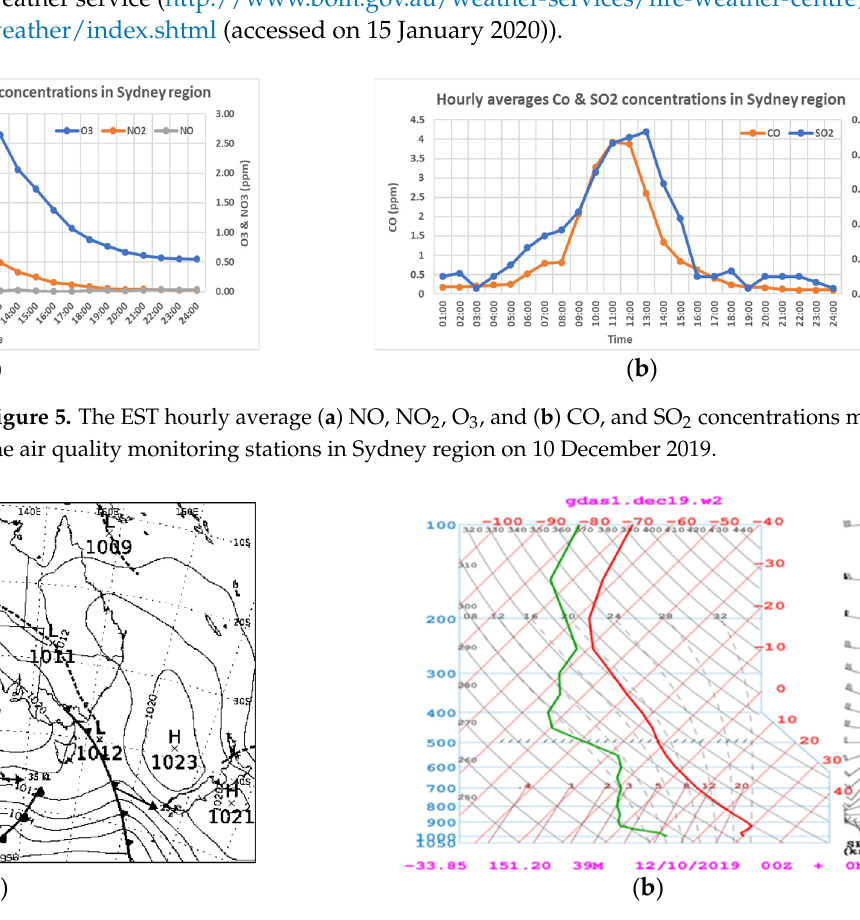
Figure 5. The EST hourly average ( a ) NO, NO 2 , O 3 , and ( b ) CO, and SO 2 concentrations measured at the air quality monitoring stations in Sydney region on 10 December 2019.